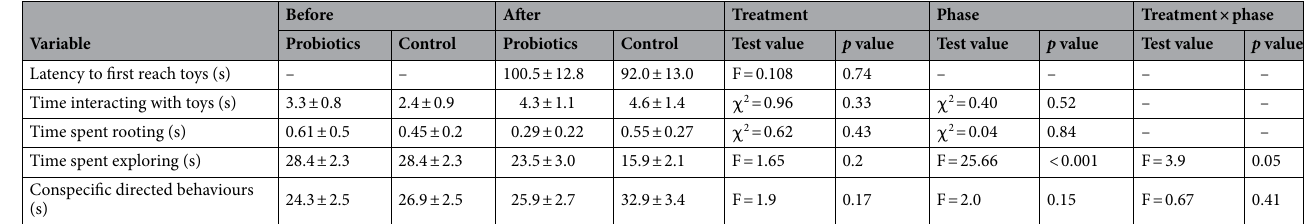
Table 1. Mean ± sem behavioural variables during the two different phases of the attention bias